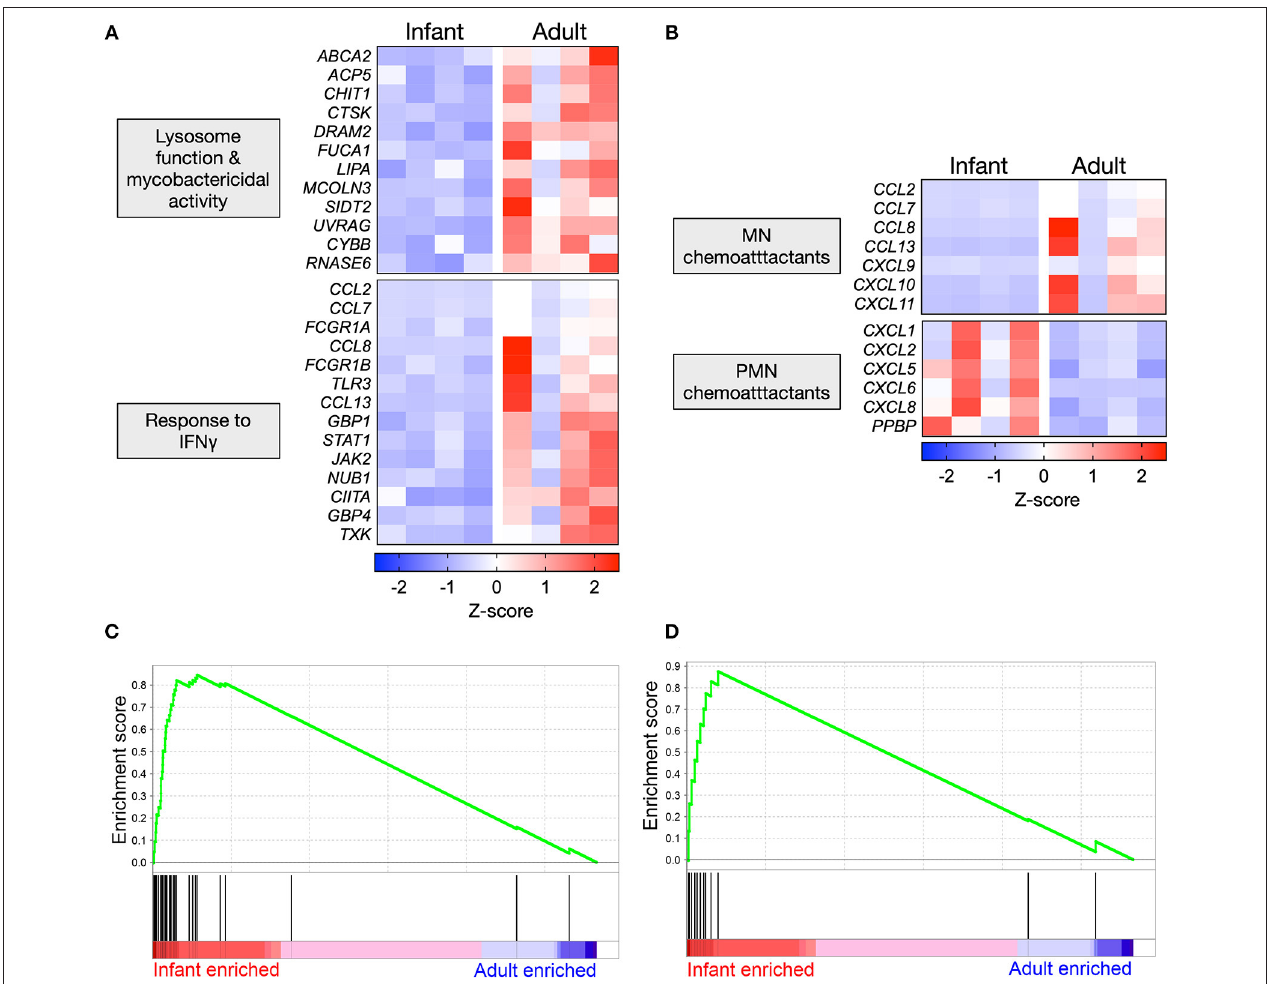
FIGURE 4 | Polarized gene expression affecting specific functional pathways in Mtb-infected AM φ s. (A) Expression profile of SDE genes in Mtb-stimulated infant vs. adult AM φ s involved in lysosome function (GO: 0000323), response to bacterium (GO:0009617) and cellular response to IFN γ (GO: 0071346); and (B) Expression profile of all SDE genes encoding chemokines in Mtb-stimulated infant vs. adult AM φ s. Scale intensity represents Z-score. (C) Enrichment of 36 genes in the transcriptome of Mtb-stimulated infant/adult AM φ s previously shown to be upregulated in AM φ in response to H37Rv Mtb relative to the avirulent H37Ra Mtb strain in ( 27); and (D) Enrichment of 12 genes in the transcriptome of Mtb-stimulated infant/adult AM φ s previously shown to be upregulated in Mtb-stimulated monocyte-derived macrophages from patients who had previously recovered from TB meningitis and pulmonary TB, relative to equivalents from patients with latent TB ( 28). GSEA plots showing all genes from Mtb-stimulated dataset ranked horizontally from highest differential expression in infants (red) to highest differential expression in adults (blue). The enrichment profile (green line) shows the degree of overrepresentation of previously published sets of genes (vertical black lines). Analysis performed using GSEA software (Version 6.3, Broad